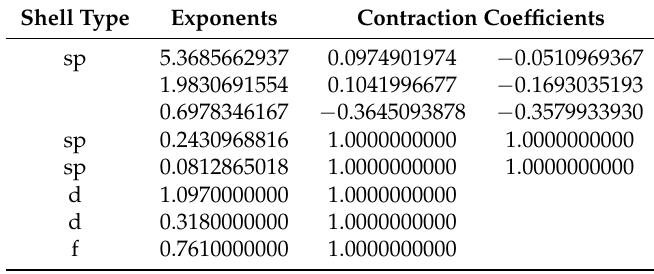
Table A7. Parameters of the cc-TZVP basis set of Carbon. Parameters taken from [80].